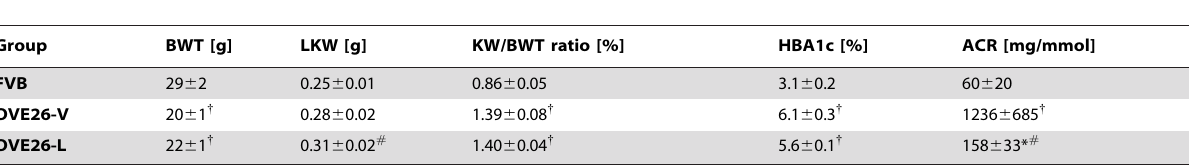
Table 1. Physical and metabolic characteristics in OVE26 and non-diabetic FVB mice.